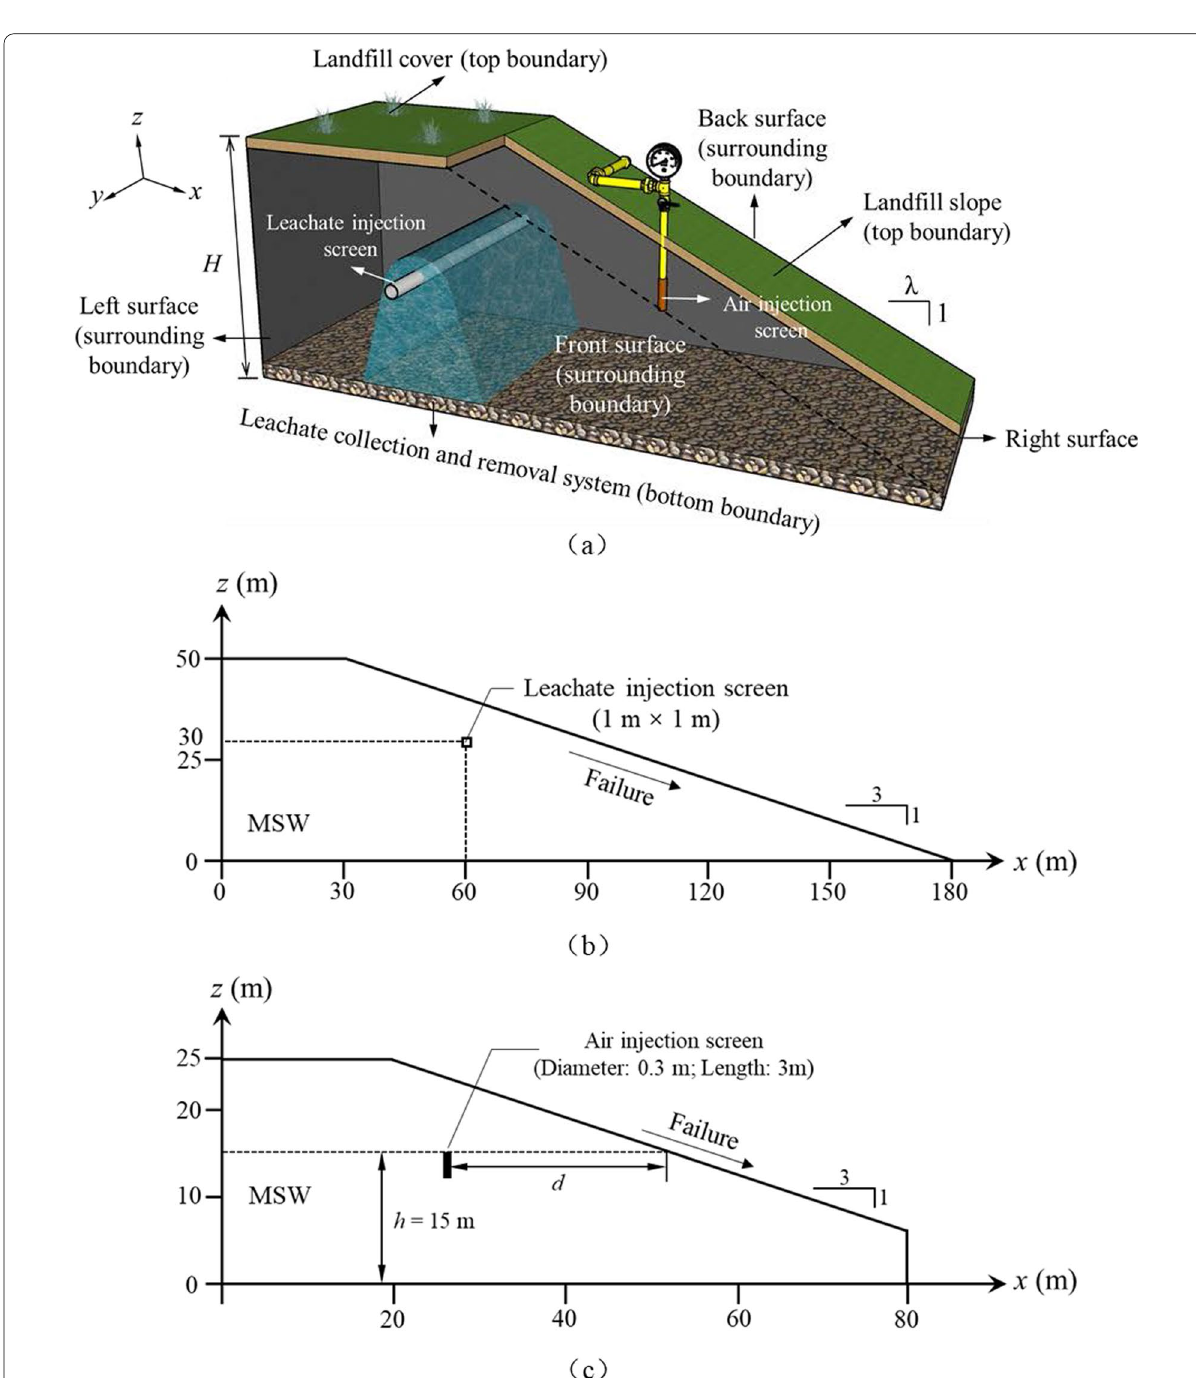
Fig. 2 Schematic of a bioreactor landfill with slope: a 3D view of the conceptual model; b cross‑sectional view of leachate injection scenario; c cross‑sectional view of air injection